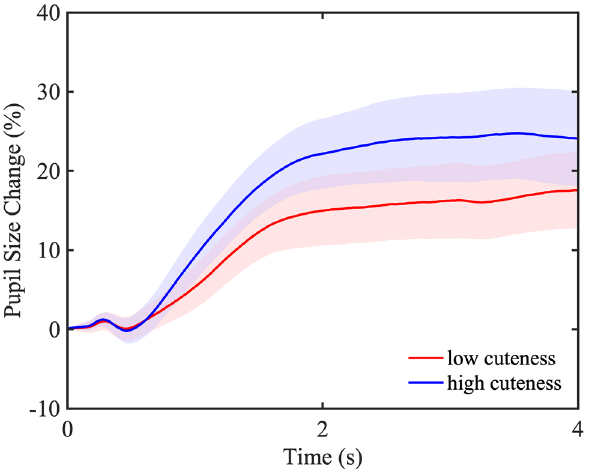
Figure 4. Dynamics of pupil change over the entire presentation time. The blue line shows the mean pupil change corresponding to the 20 images with a high cuteness rating, and the red line shows the mean pupil change corresponding to the 20 images with a low cuteness rating. The blue-colored area indicates a 95% confidence interval for the images with high cuteness rating, and the red-colored area indicates a 95% confidence interval for the images with low cuteness